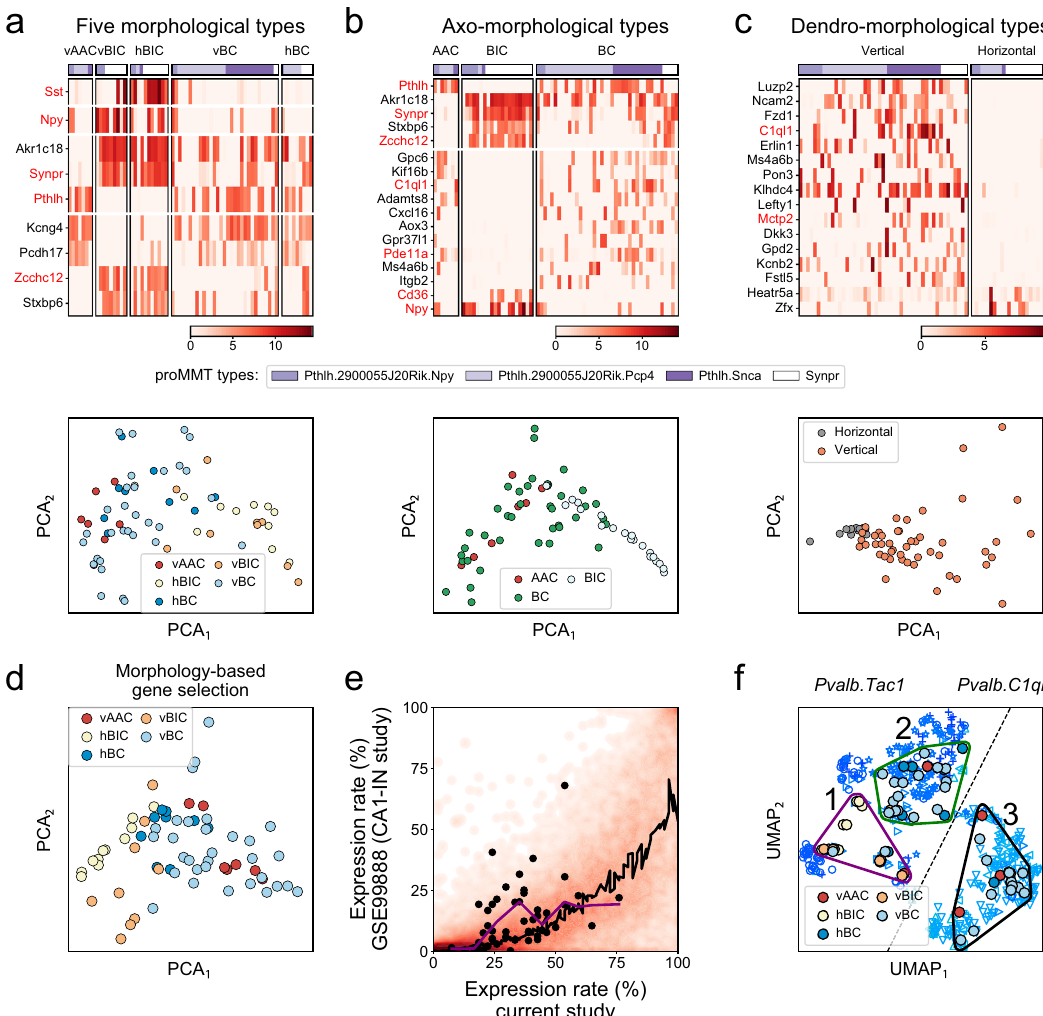
Fig. 4 Transcriptomic correlates of morphological PV types. a – c Heat maps (upper plots) of differentially expressed genes (using edgeR, fold difference>2, FDR < 0.05) between the fi ve morphological PV types (panel a ), three axo-morphological types (panel b ), and two dendro-morphological types (panel c ). Cells are ordered according to proMMT types. Genes that also appeared in proMMT comparisons (Fig. 2c) are highlighted in red. PCA plots (lower plots) were made using the differentially expressed genes. d PCA plot of cells, colored by the fi ve morphological PV types, using an extended set (with a cutoff of FDR < 0.15) of n = 52 differentially expressed genes from panels a to c . e Comparison of expression rate of genes in PV-INs from this current versus the CA1-IN study 10 , displayed as a heatmap. Black line marks the loess regression fi t. Black points label the 52 differentially expressed genes (with a cutoff of FDR < 0.15) from a to c . f UMAP-based embedding of PV-INs from the CA1-IN study 10 , and mapping the PV-INs of this current study onto the UMAP embedding using the extended set of n = 52 differentially expressed genes (with a cutoff of FDR < 0.15) from panel a to c . Three clusters of mapped cells are shown (labeled as 1, 2, and 3) as determined by K-means clustering. Symbols refer to the following transcriptomic subtypes, as described in the original study: rightward triangle Pvalb.Tac1.Akr1c18 , leftward triangle Pvalb.Clql1.Cpne5 , upward triangle Pvalb.C1ql1.Npy , downward triangle Pvalb.Clql1. Pvalb , plus sign Pvalb.Tac1.Nr4a2 , open circle Pvalb.Tac1.Sst , and star Pvalb.Tac1.Syt2 . The dashed line separates Pvalb.Tac1 and Pvalb.C1ql